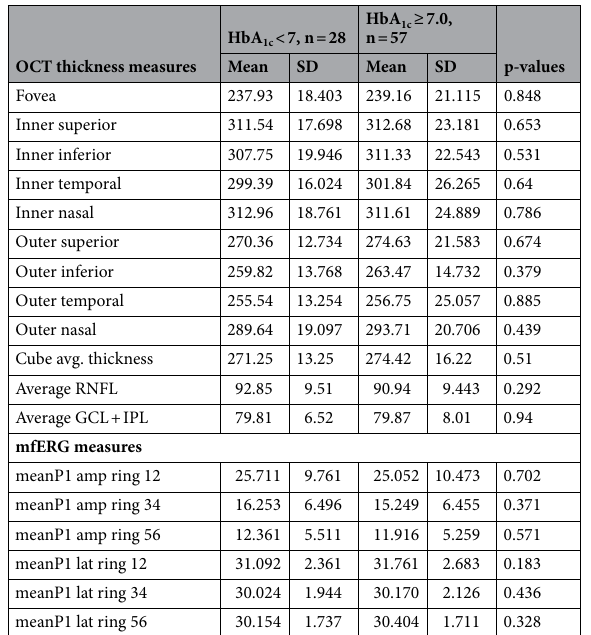
Table 2. OCT and mfERG measures stratified according to HbA 1c . Latencies expressed as milliseconds; amplitude assessed as response density, nV/deg 2 .